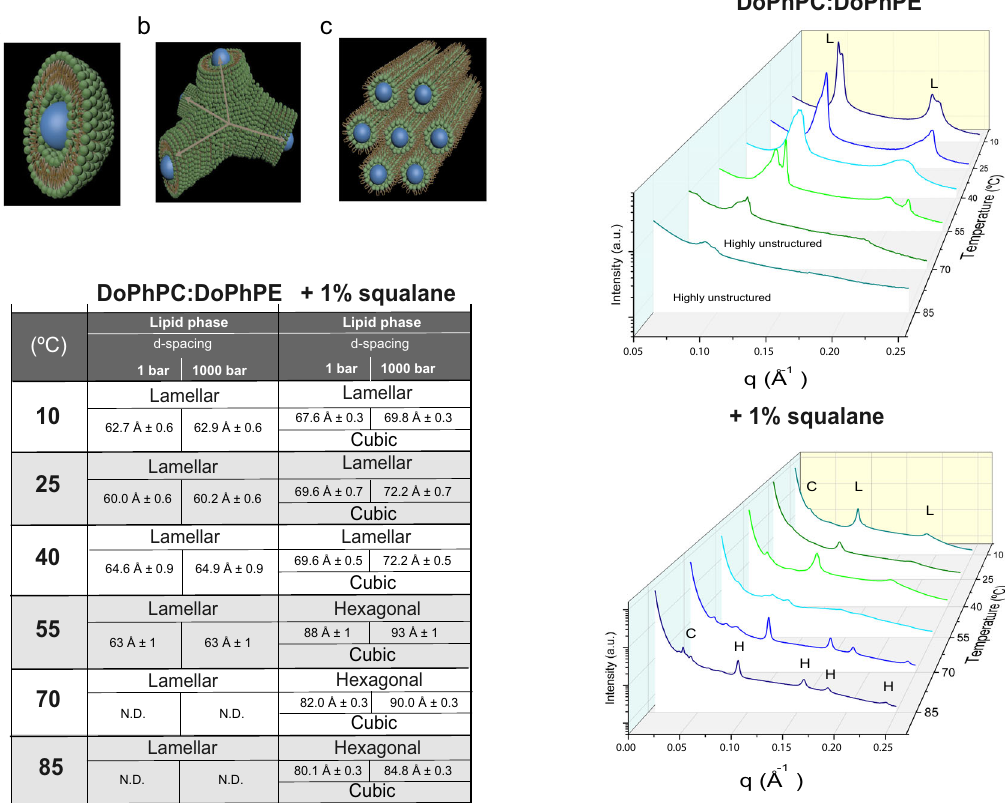
Fig. 3 Squalane induces lipid self-assembly in highly curved non-lamellar phases. Top left: 3D representations of different lipid phases: a lamellar, b Pn3m (cubic), and c hexagonal. Table: lipid phases present in DoPhPC:DoPhPE (9:1) in the absence or presence of 1 mol% squalane at different temperatures and hydrostatic pressures. The lattice parameters (d-spacing) obtained at 1 bar and 1000bar for the lamellar and hexagonal phases measured at I22 (DLS, Didcot, UK) are given. N.D. stands for “ Not Detected ” . Right: radial SAXS intensities of DoPhPC:DoPhPE (9:1) in the absence (top) and presence of 1 mol% squalane (bottom) at different temperatures. Phases could be identi fi ed by the ratios of the scattering vectors at which Bragg peaks are located (lamellar (L) phase: 1:2:3; cubic (C) phase: √ 2: √ 3:2: √ 6; and hexagonal (H) phase: 1: √ 3:2: √